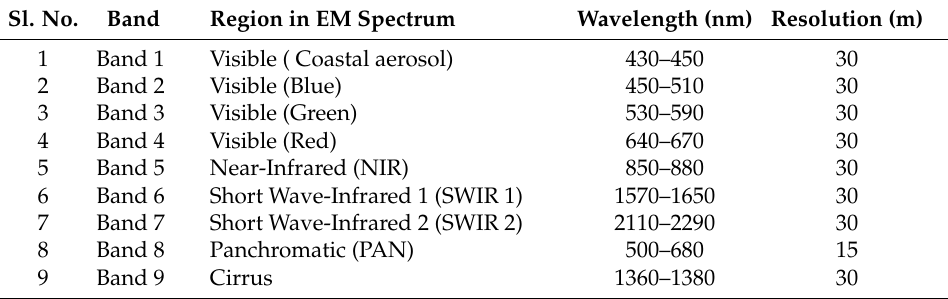
Table 1. Landsat 8 Operational Land Imager (OLI) spectral band details. Sl.